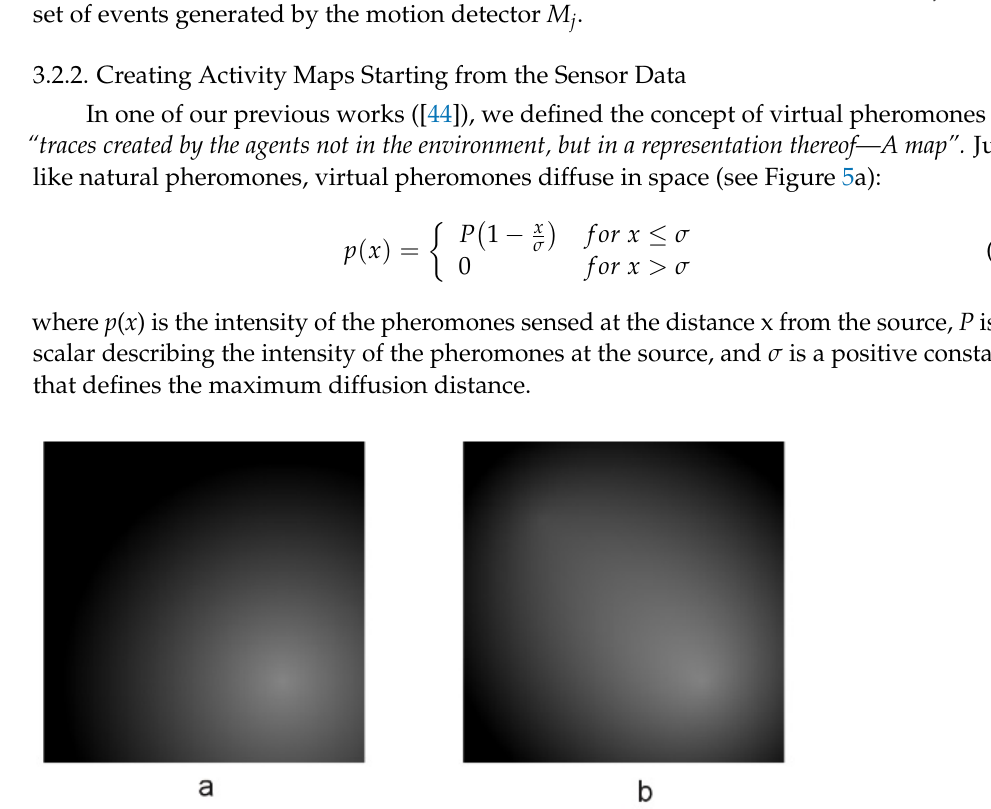
Figure 5. ( a ) Grayscale image (128 × 128 pixels) illustrating the process of spatial diffusion from a single pheromone source placed in P4. ( b ) A similar image illustrating the superposition of the effects of two pheromone sources placed in P1 and P4. The intensity of the pheromone is encoded in shades of gray, where black corresponds to locations with no pheromone at all, and white corresponds to locations with maximum intensity of pheromones.